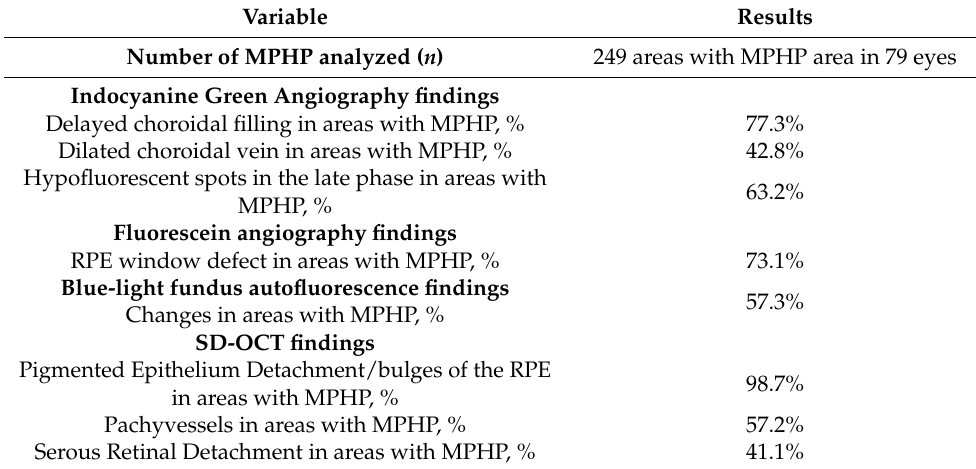
Table 4. Multimodal analysis of the areas with mid-phase hyperfluorescent plaques (MPHP) on indocyanine green angiography in patients with central serous chorioretinopathy.